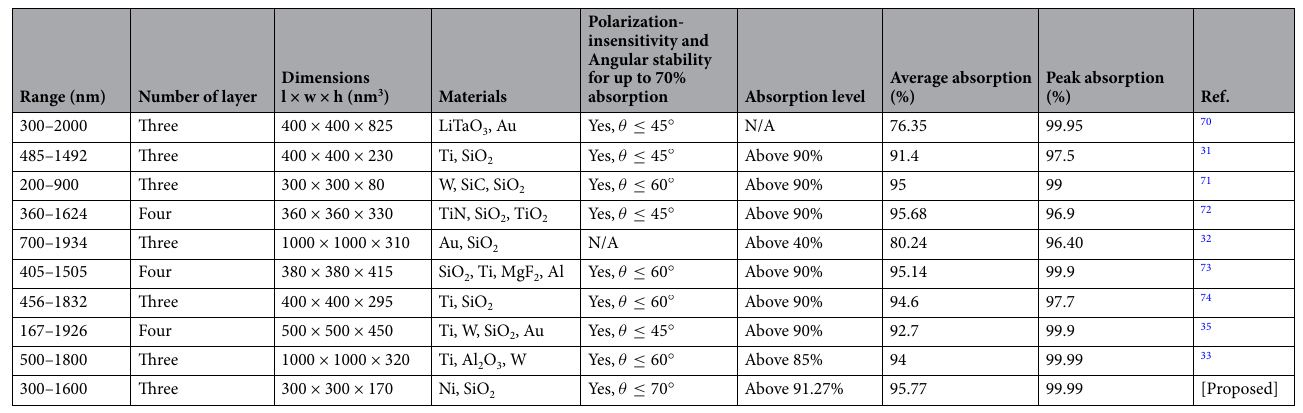
Table 3. Comparison table of the proposed model with previously published